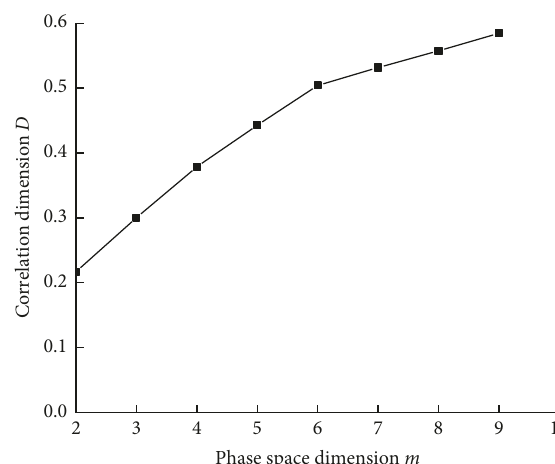
Figure 7: Relationship curve between phase space dimension m and correlation dimension D